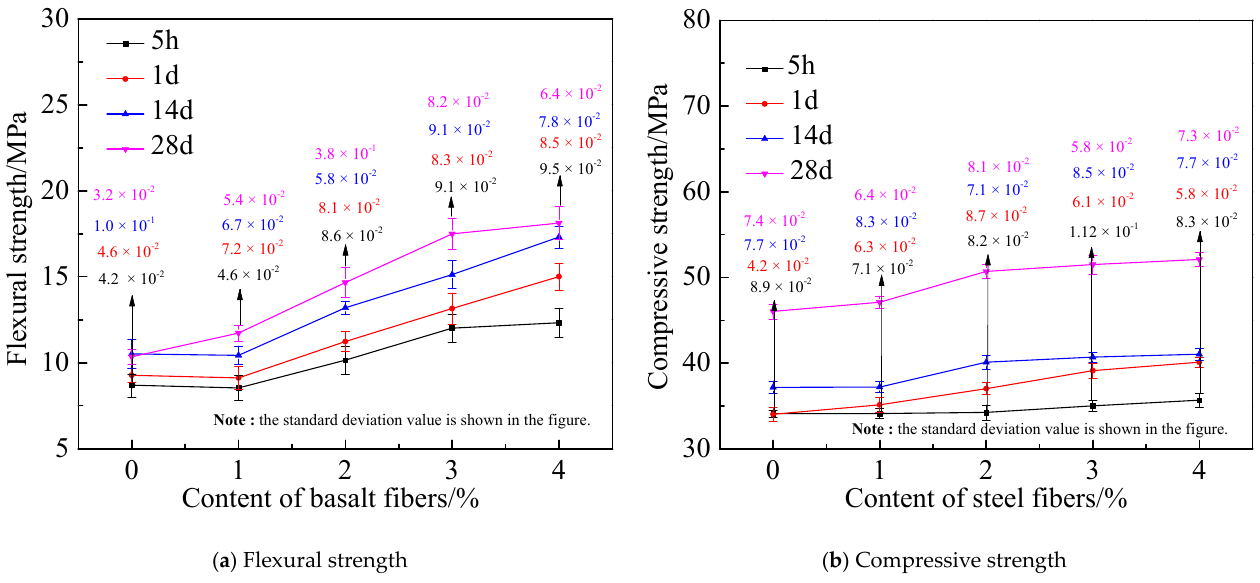
Figure 3. The mechanical strength of basalt fibers reinforced SAC-RPC.